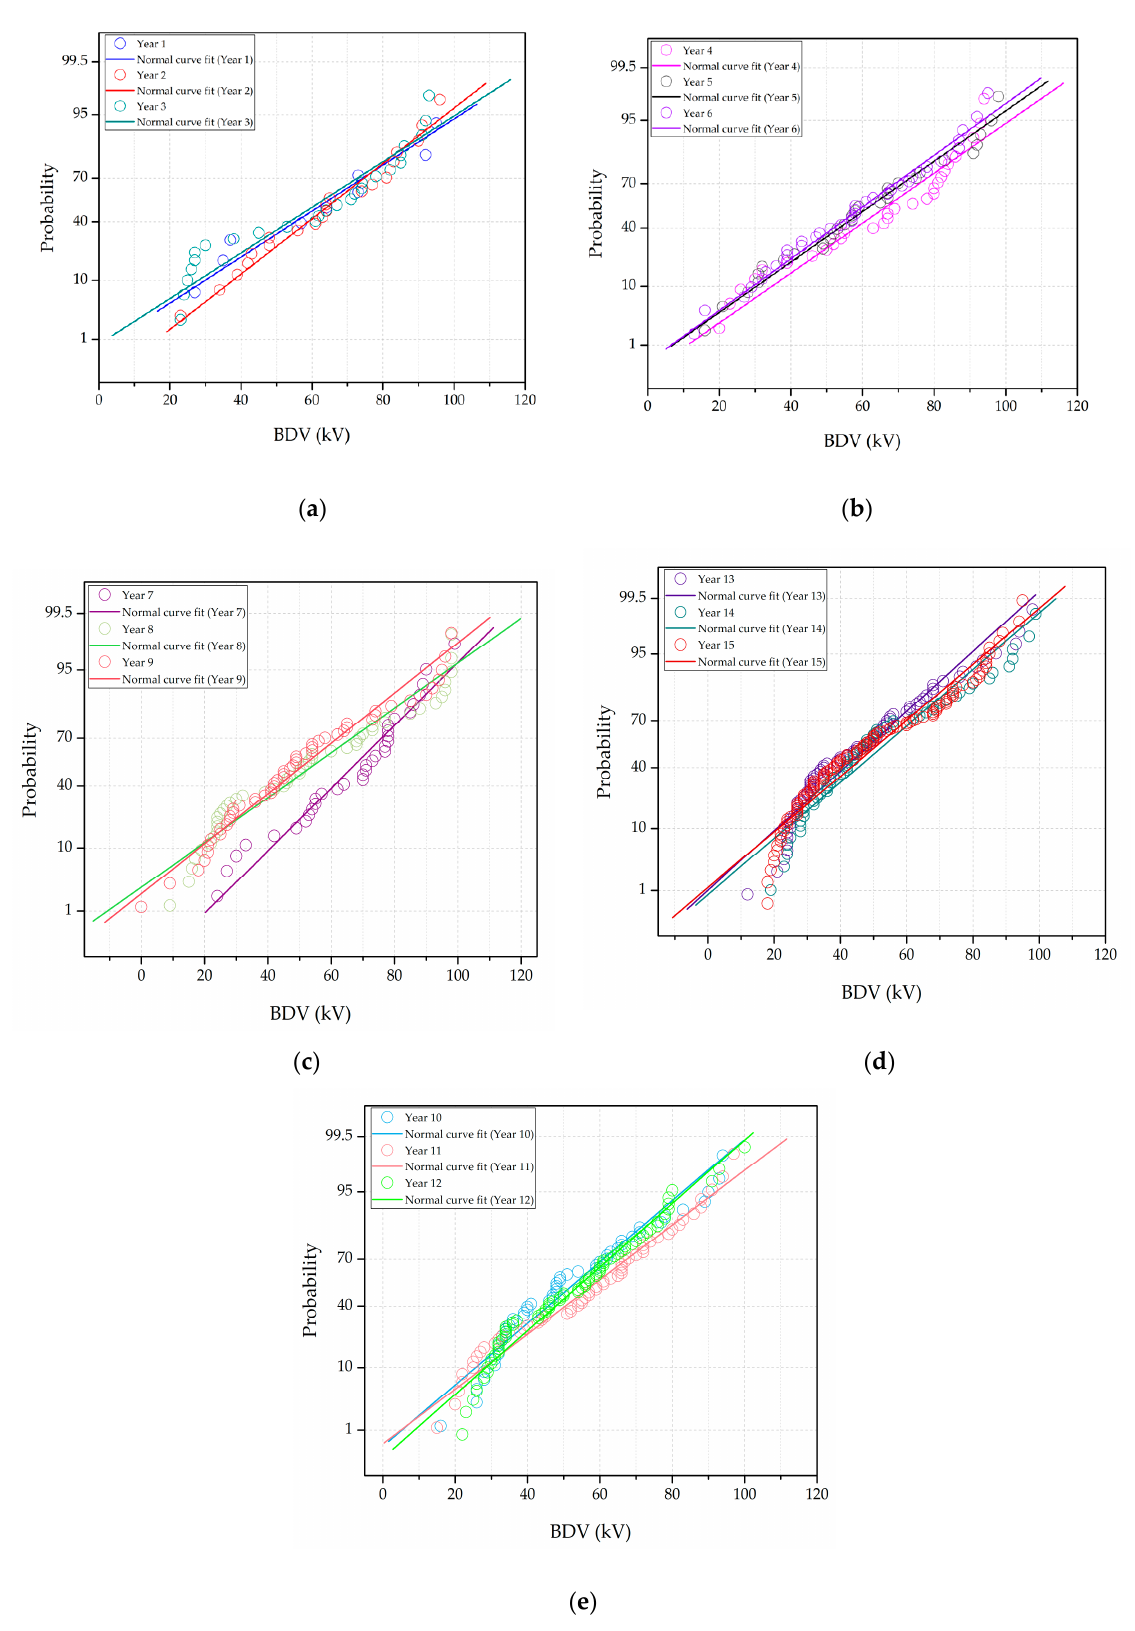
Figure 2. Normal distribution probability plot for dielectric breakdown voltage from year ( a ) 1 to 3; ( b ) 4 to 6; ( c ) 7 to 9; ( d ) 10 to 12; and, ( e ) 13 to 15.